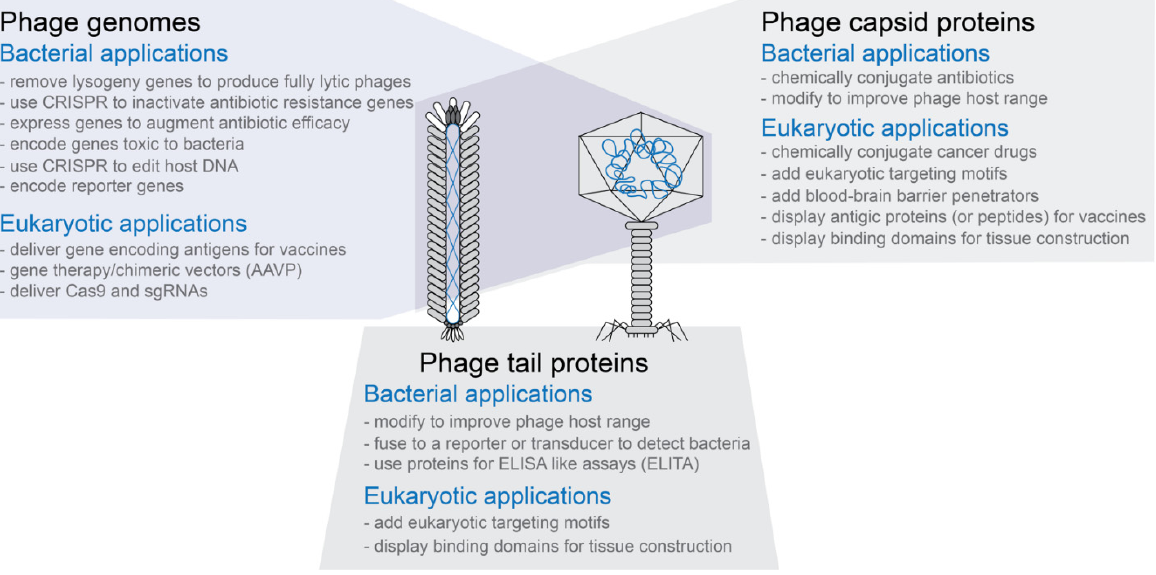
Figure 1. Overview of engineered phages. Both filamentous and tailed phages have been modified to create phages with novel functions. The three modification types are not exclusive of each other. That is, for example, phages in which both the capsid and tail fibers have been modified have been designed and produced.